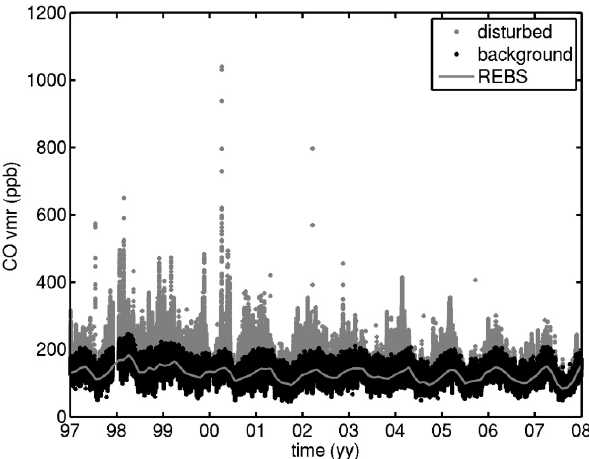
Fig. 3. Time series of NDIR CO concentrations (in ppb) at Jungfraujoch: the complete dataset before filtering (grey) and the dataset after REBS-CNR filtering (black; the grey curve is the REBS-CNR fit).